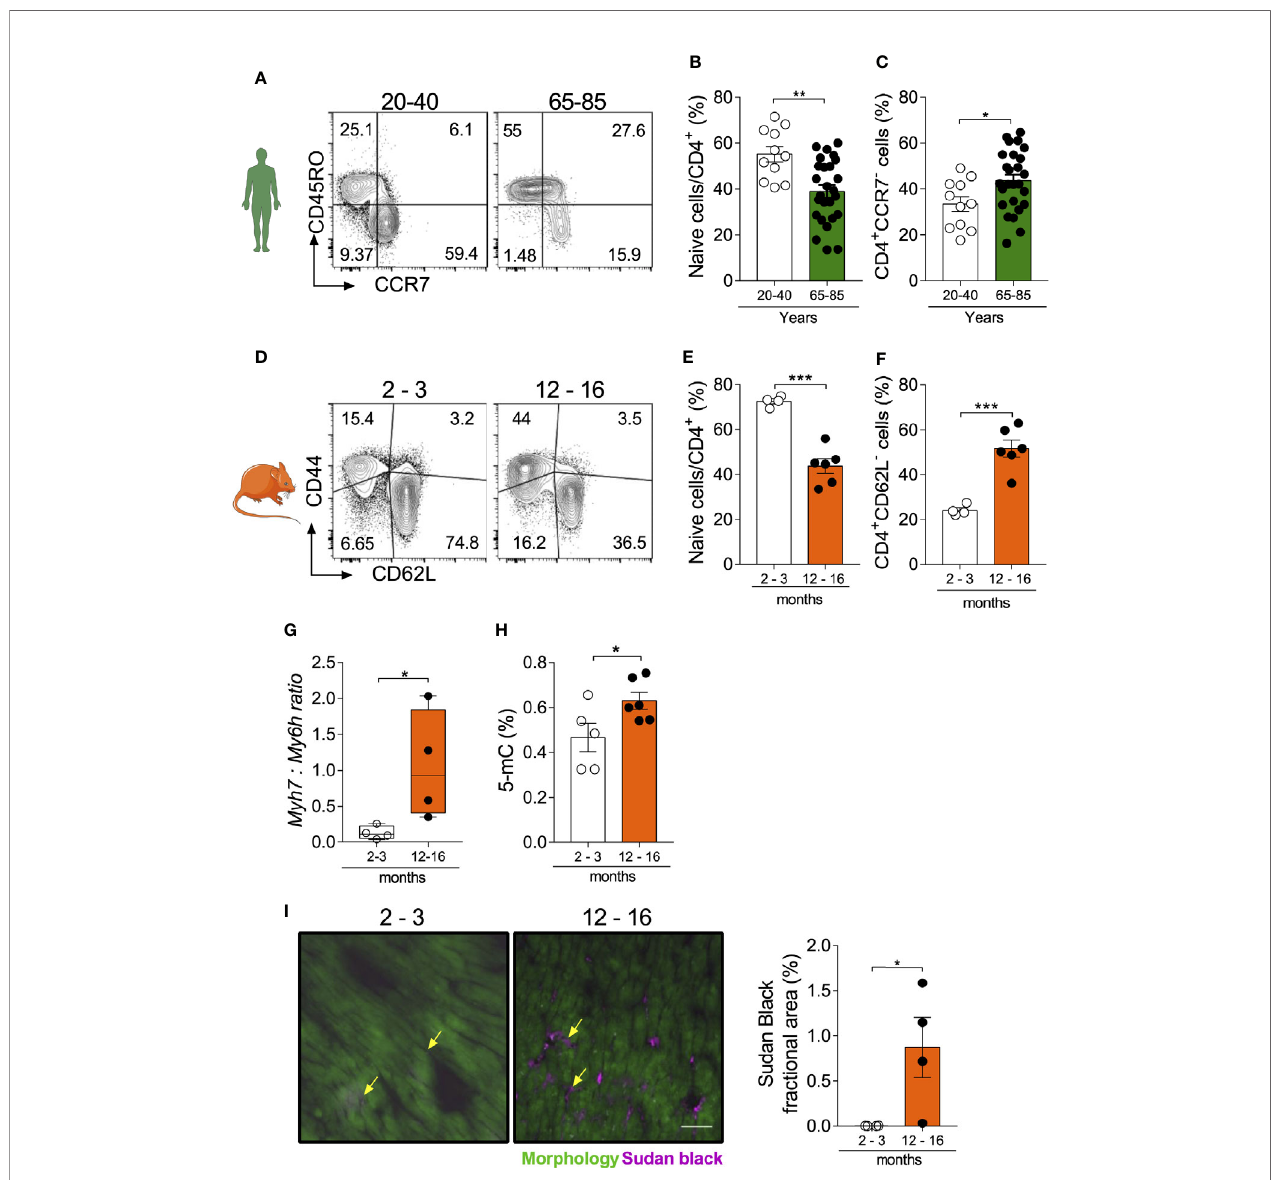
FIGURE 1 | Myocardial and immunosenescence phenotypes develop synchronously. (A) FACS strategy depicts the frequency of human naïve CD4 + T cells (CD45RO - CCR7 + ) and the effector memory population (CD45RO + CCR7 - ). Aging is accompanied by a reduction in naïve CD4 + T cells (B) , while effector memory/ terminally differentiated cells increase (C) . (D) FACS strategy shows the distribution of naïve (CD44 - CD62L + ) and effector memory (CD44 + CD62L - ) CD4 + T cells in the spleen of young (2 – 3 months) and aged (12 – 16 months) mice. The frequency of naïve CD4 + T cells is reduced in aging (E) , while effector memory and terminally differentiated cells increase (F) . In immunocompetent WT animals, aging is associated with and higher myh7:myh6 expression ratio (G) and increased levels of heart DNA methylation (H) . (I) Immuno fl uorescence of lipofuscin granules and its quanti fi cation in heart tissue from young and aged mice. Yellow arrows depict lipofuscin stained areas in both groups. Scale-bar: 100 µm. The bar graphs display the group mean values (bar), the SEM and the distribution of each individual value. Statistical analysis in (B – I) : Two-tailed unpaired t test, *** P < 0.001, ** P < 0.01 and * P <